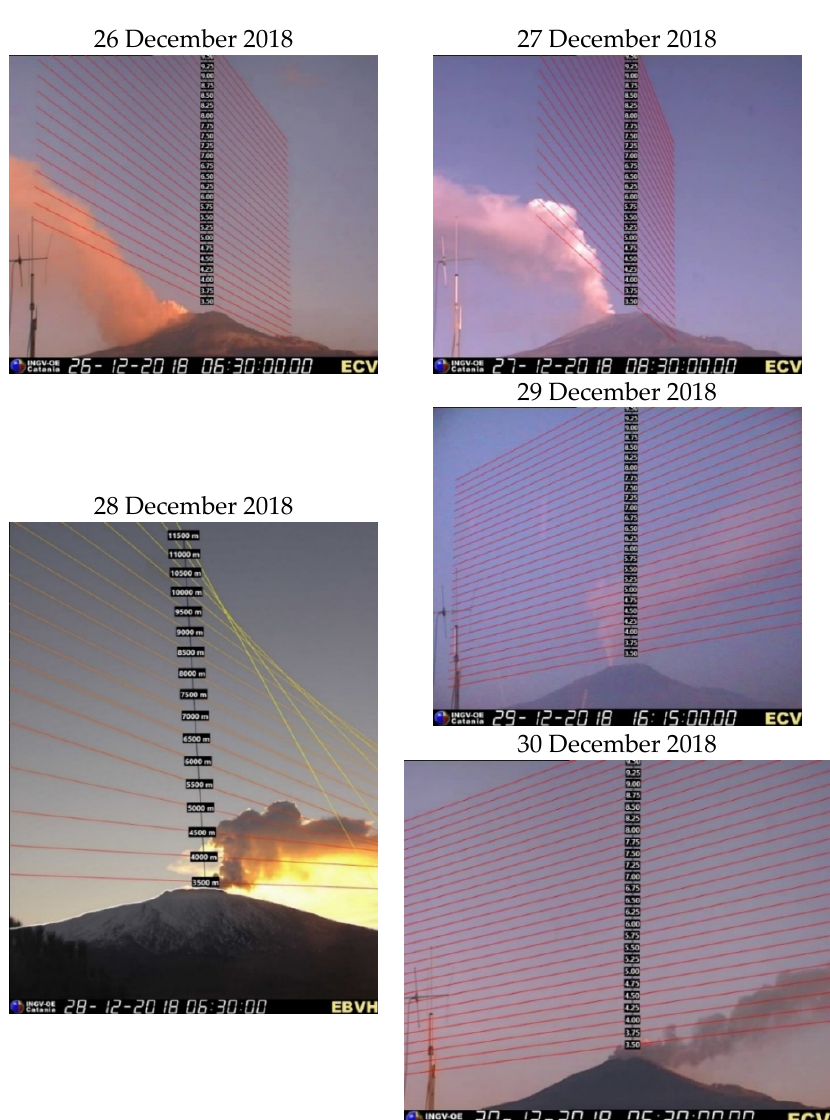
Figure 6. Images observed by the visible (VIS) cameras between 26–30 December 2018 of the Etna eruption. The ECV camera is installed in Catania at Catania (CUAD) station south of Mt Etna, while EBVH in Bronte on the western flank of the volcano.